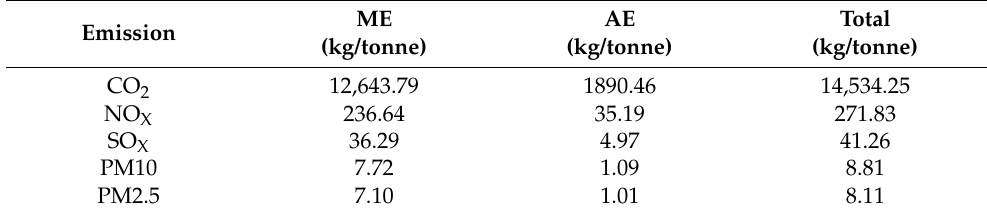
Table 5. Exhaust Emission Inventory for